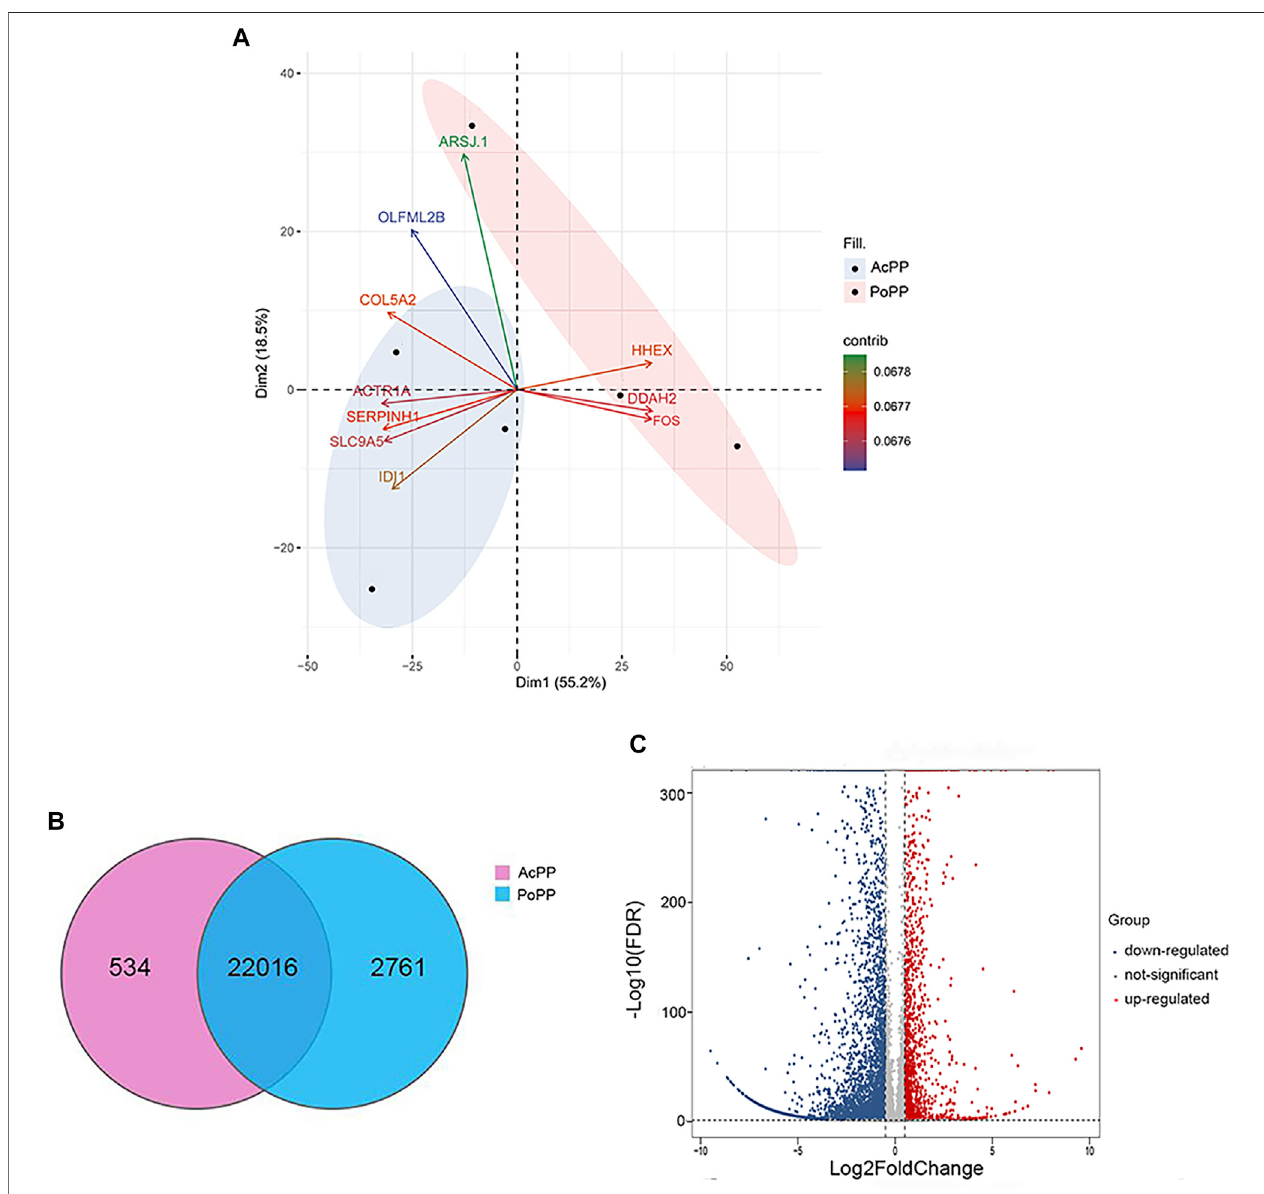
FIGURE3| Analysesofthedifferentiallyexpressedgenes(DEGs)intheAcPPcomparedwiththoseinthePoPP. (A) Principalcomponentanalysis(PCA)ofDEGsin the sixPP samples. The fi rst two eigenvalues were plotted with data ellipses for each sample using the con fi dence intervals of 0.95. Itis to be noted that the PCA results clearly separated the AcPP group (blue ellipse) from the PoPP group (pink ellipse); and the biplot showed the top ten genes contributing to the PCA in Panel. (B) Venn diagram showing the total number of expressed genes in the AcPP and the PoPP. The overlapping region indicates the shared genes (22,016); 534 genes were speci fi callyexpressedintheAcPPand2,761genesinthePoPP. (C) Volcanoplotshowingdownregulated(blue)andupregulated(red)DEGsbasedonthecriteriasetat| log2 (fold change)| > 0.5 and FDR < 0.01 as cutoff.